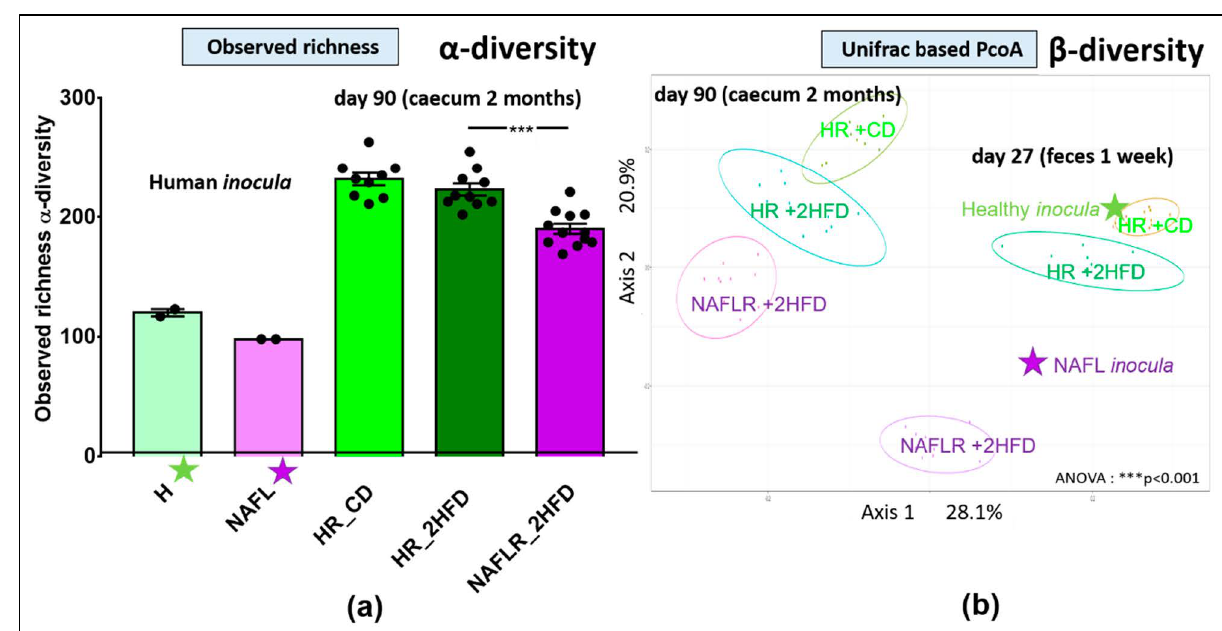
Figure 2. 16S rRNA inocula , fecal and caecal microbiome analysis. ( a ) Observed richness, n = 12 mice/group, *** p < 0.001 for microbiota statistical impact (NAFLR_2HFD vs. HR_2HFD). ( b ) Unifrac-based PcoA, ANOVA: *** p < 0.001. PcoA, principal coordinate analysis; green star, healthy human microbiota; purple star, NAFL human microbiota; HR, healthy human microbiota receiver mice; CD, control diet; 2HFD, high-fructose, high-fat diet; NAFLR, NAFL patient microbiota receiver mice; HR_CD, HR mice on CD; HR_2HFD, HR mice on 2HFD; NAFLR_2HFD, NAFLR mice on 2HFD; day 27, one week after FMT; day 90, 10 weeks after FMT.